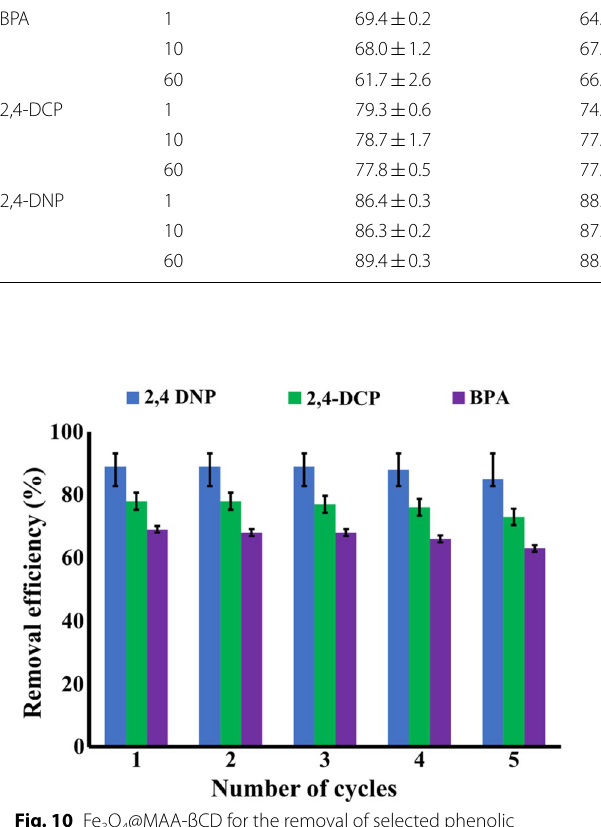
Table 5 Removal (%) and RSD ( n Water sample